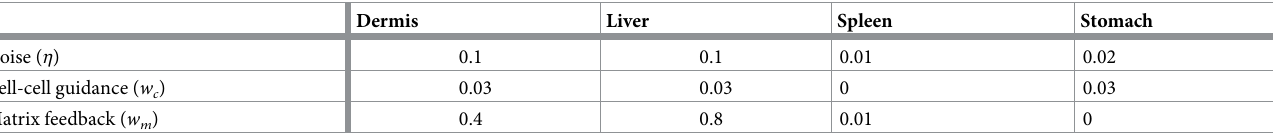
Table 1. Differences in parameter values for generating in silico matrix in Fig